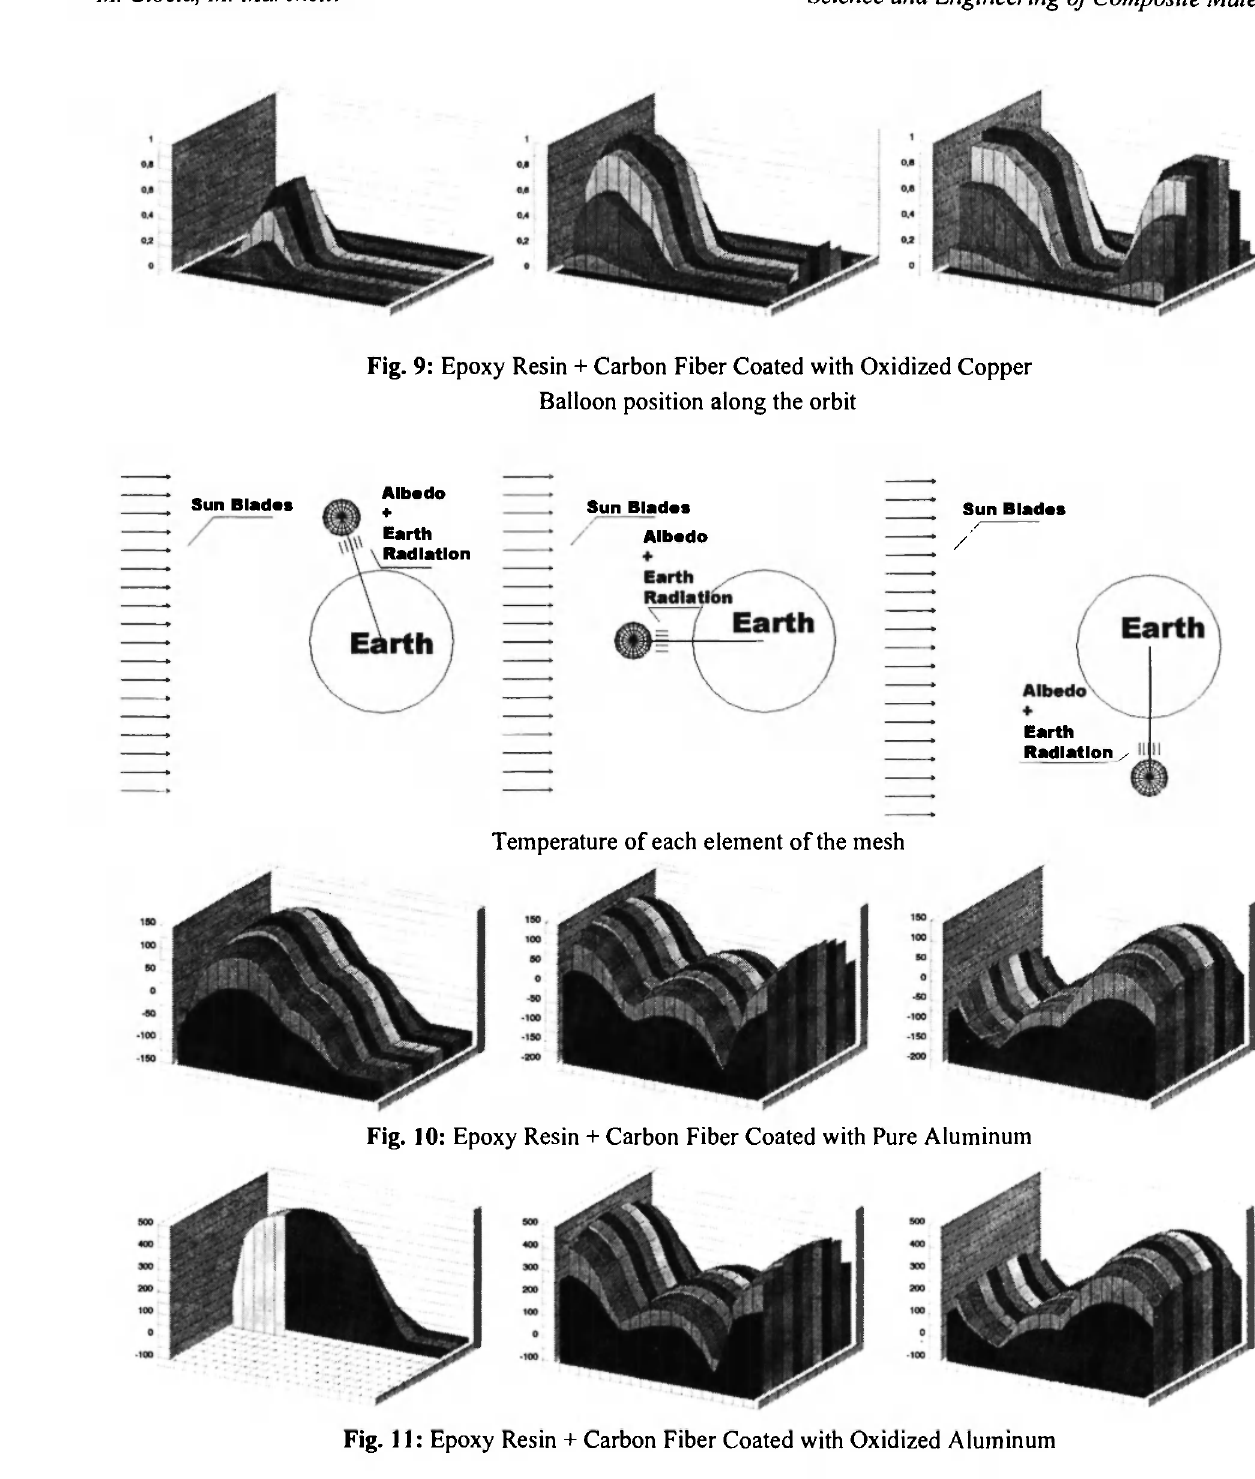
Fig. 11: Epoxy Resin + Carbon Fiber Coated with Oxidized Aluminum